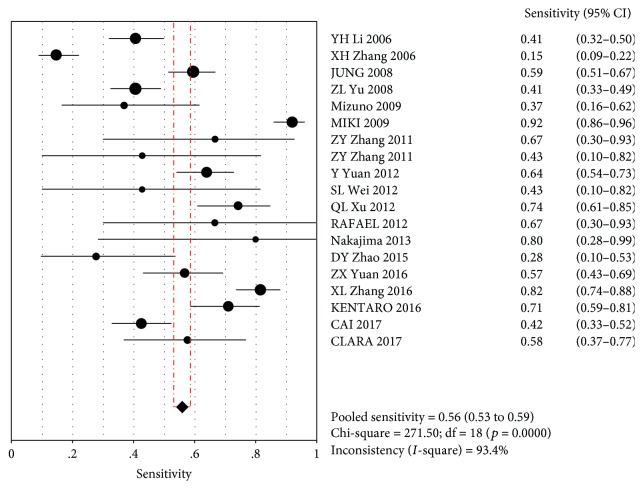
Consolidation sensitivity.